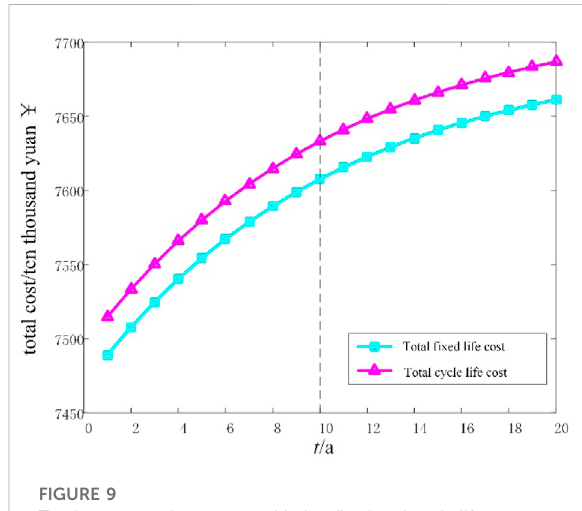
FIGURE 9 Total cost growth curve considering fi xed and cycle